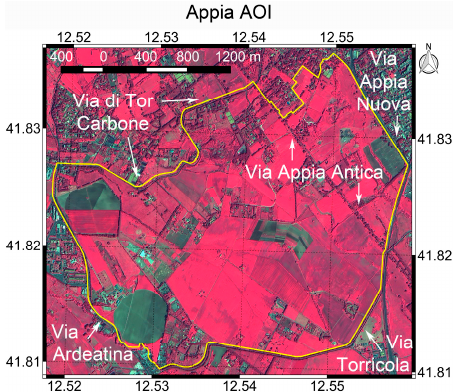
Figure 20. Kompsat-2 image of the Appia AOI (shown in yellow polygon) acquired on 21 April 2011, pansharpened to 1 m spatial resolution. False colour composite of NIR, R and G displayed as R, G and B respectively. Kompsat-2 data provided by the European Space Agency.